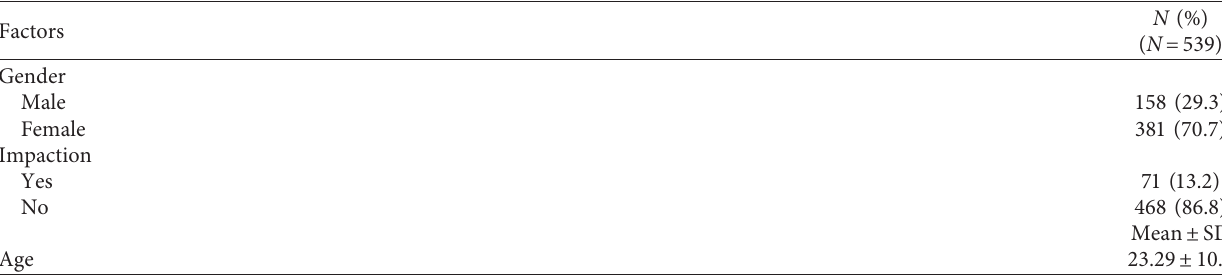
Table 1: Descriptive statistics of the study